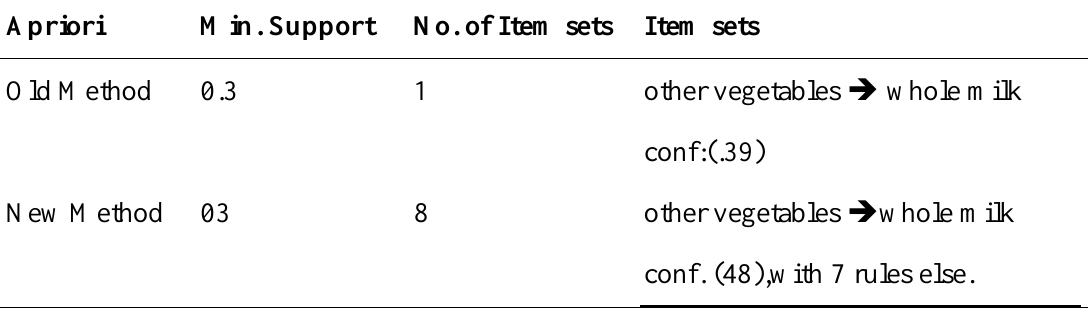
Table 4. Table of implementing apriori algorithm before and after the new technique Apriori Min.